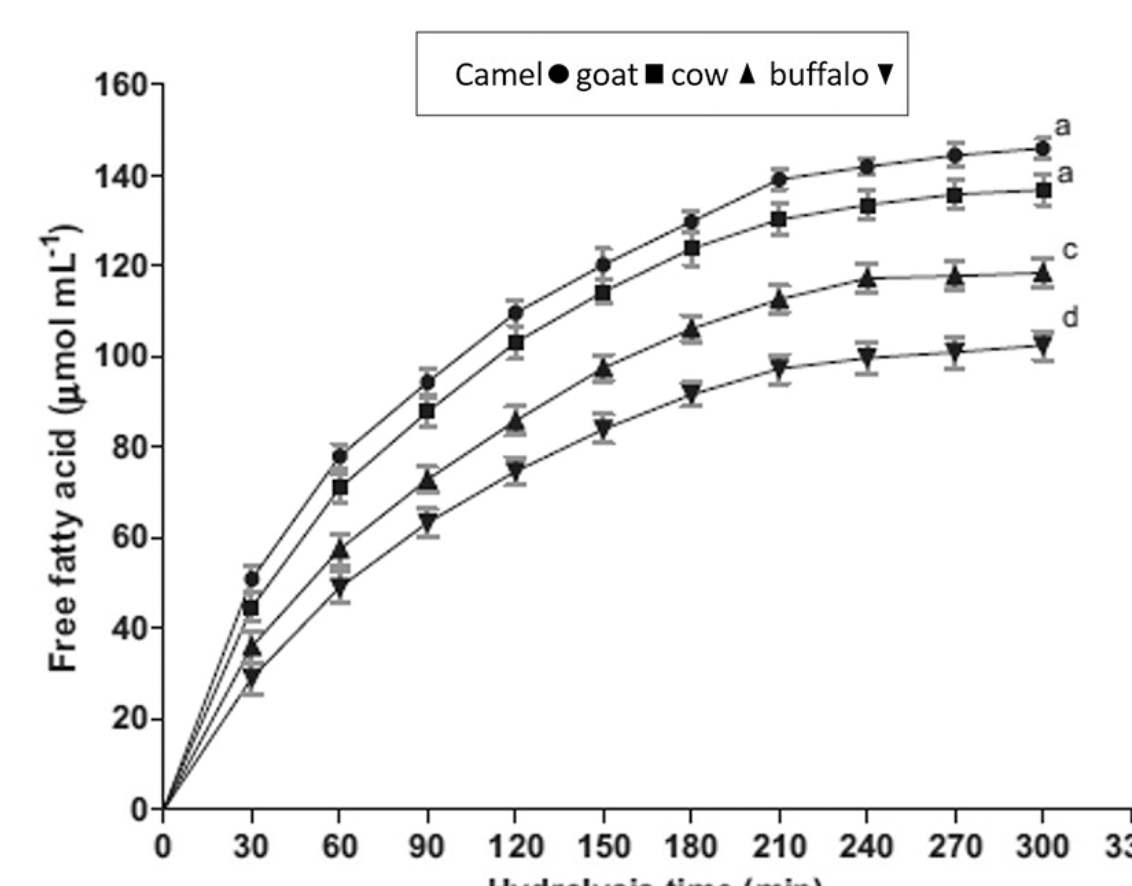
Figure 4. Comparison of the free fatty acid amount released during digestion from different kinds of milk. Reprinted with permission from Ref. [10]. Copyright 2014 Elsevier.